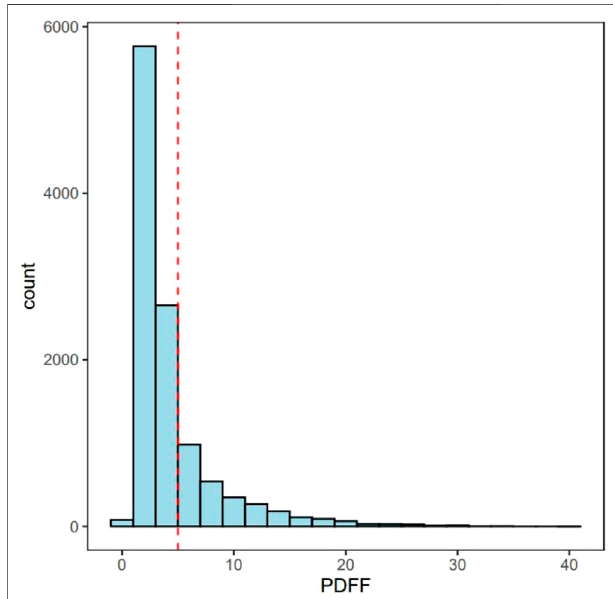
FIGURE 1 | The distribution of PDFF. Red line represents 5% of PDFF. MRI-PDFF < 5% are Non-NAFLD participants and MRI-PDFF ≥ 5% are de fi ned as NAFLD